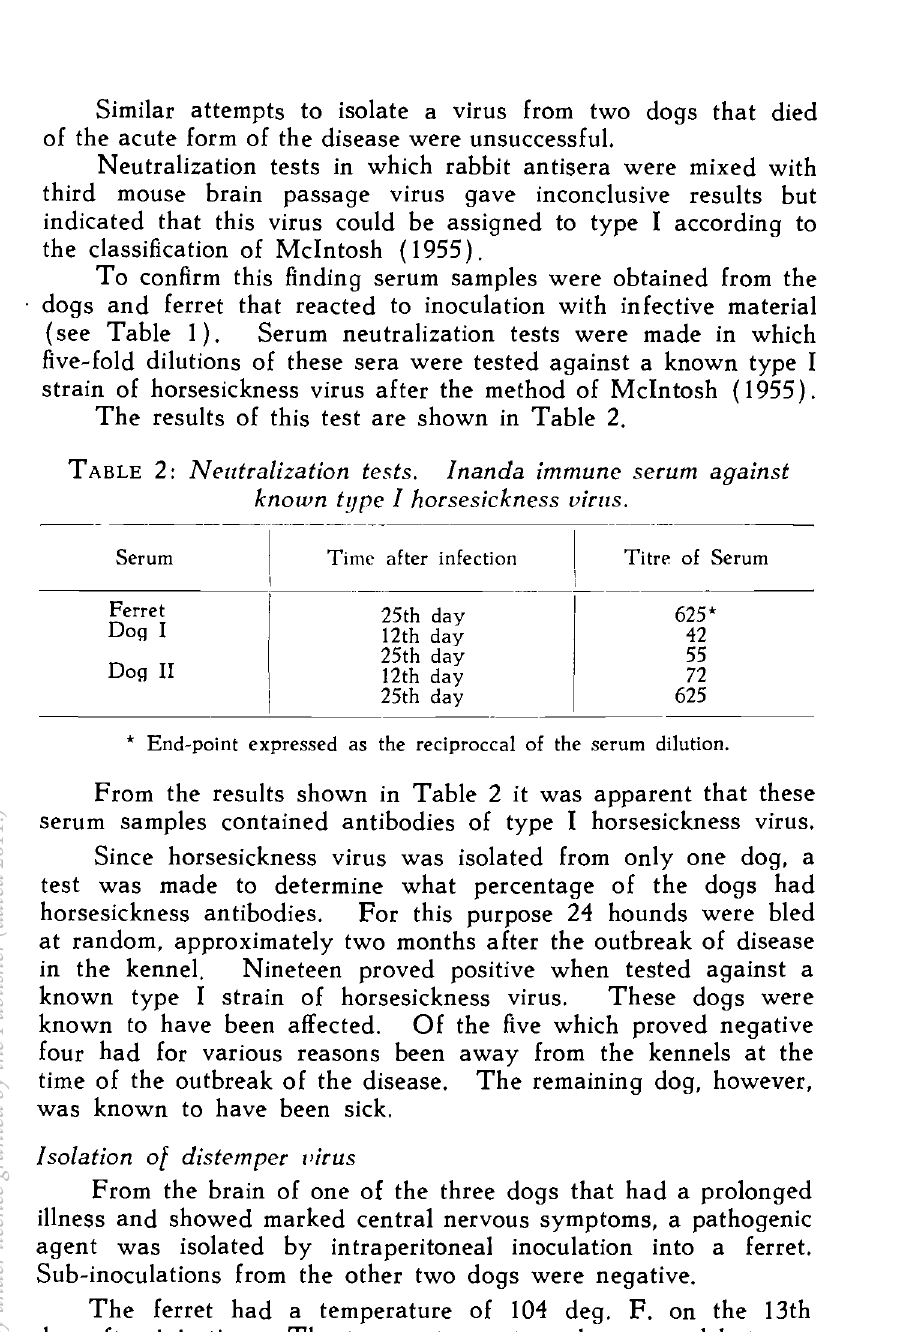
TABLE 2: Nelltralization tests. Inanda immune serum against known type I horsesickness